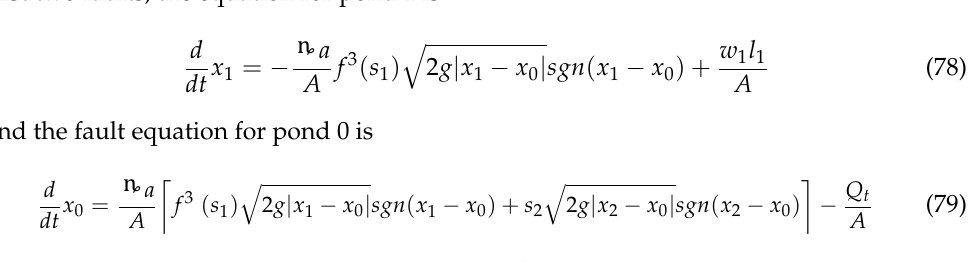
Figure 1. Three-pond hydraulic